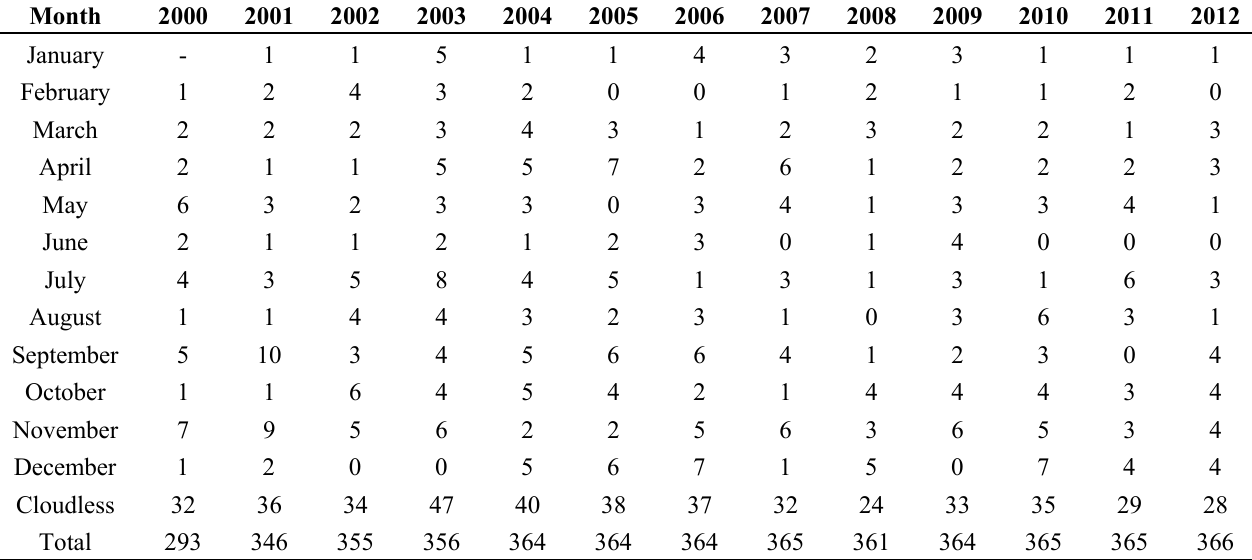
Table 1. Number of cloudless MODIS images in each month from 2000 to